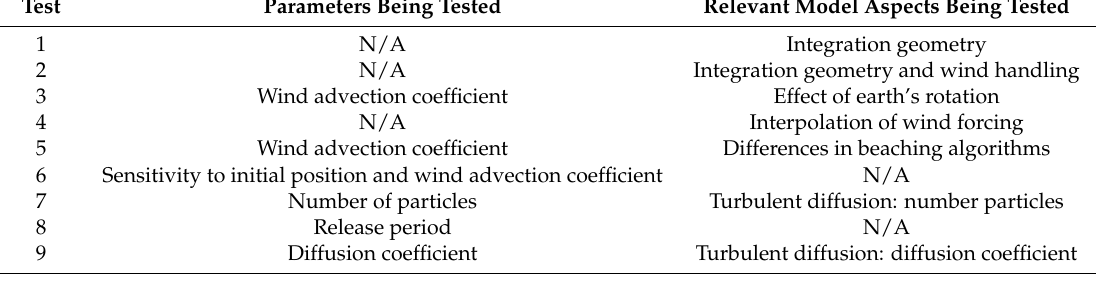
Table 13. Relation between test number, user-defined parameters, and model aspects being tested.